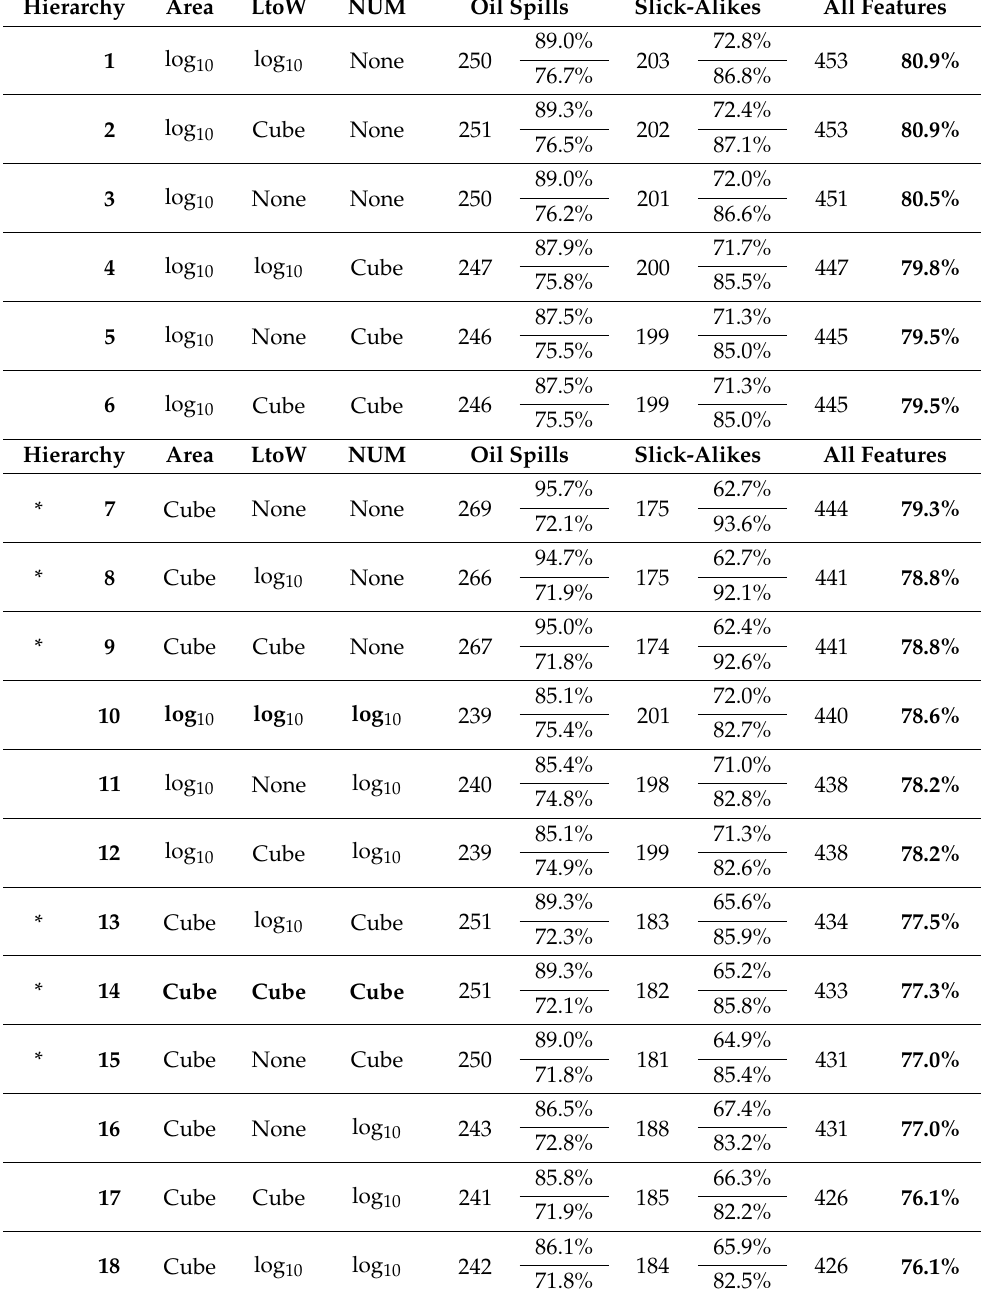
Table 7. Classification accuracy hierarchy of the 27 algorithms using three attributes subjected to dif- ferent data transformations in the same analysis—morphological characteristics (“Size Assemblage”: area, aspect ratio (length-to-width ratio: LtoW), and number of parts of each feature (NUM)). The explanation of the hierarchy blocks: 1–6, 7–18, and 19–27 is given in the text. * indicates unbalanced identification rate: algorithms correctly identifying 30% or more oil spills than look-alike slicks. ! indicates void algorithms: at least one performance metric below 60%, i.e., specificity. Bold font indicates baseline combinations with the same transformation. For the interpretation of thick table lines see Section 4.3.2. Detailed statistical information is found in Figure 4. See also Tables 1 and 6, and Section 4.3: Experiment 2